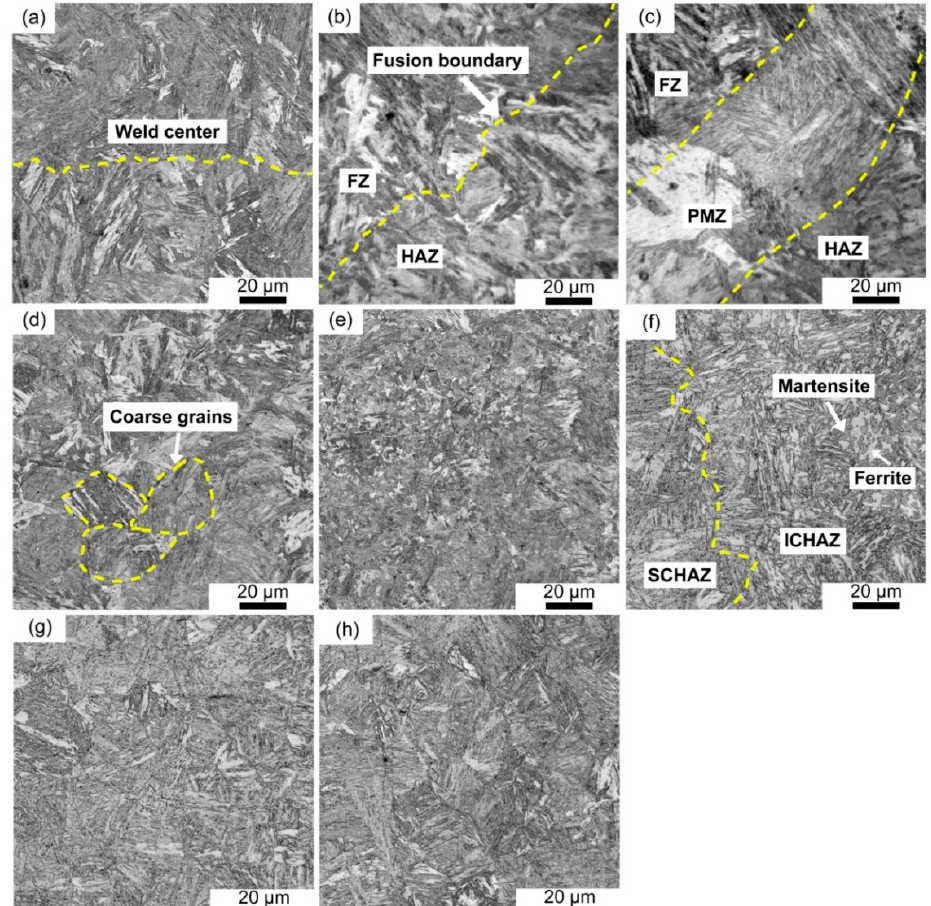
Figure 11. Optical photographs showing microstructures of the specimens: ( a ) Fusion zone (FZ) in the two-step RSW; ( b ) PMZ in the one-step RSW; ( c ) PMZ in the two-step RSW; ( d ) coarse-grain heat affected zone (CGHAZ) in the two-step RSW; ( e ) fine-grain heat affected zone (FGHAZ) in the two-step RSW; ( f ) inter-critical heat affected zone (ICHAZ) in the two-step RSW; ( g ) SCHAZ in the two-step RSW; ( h ) base metal (BM) in the two-step RSW.